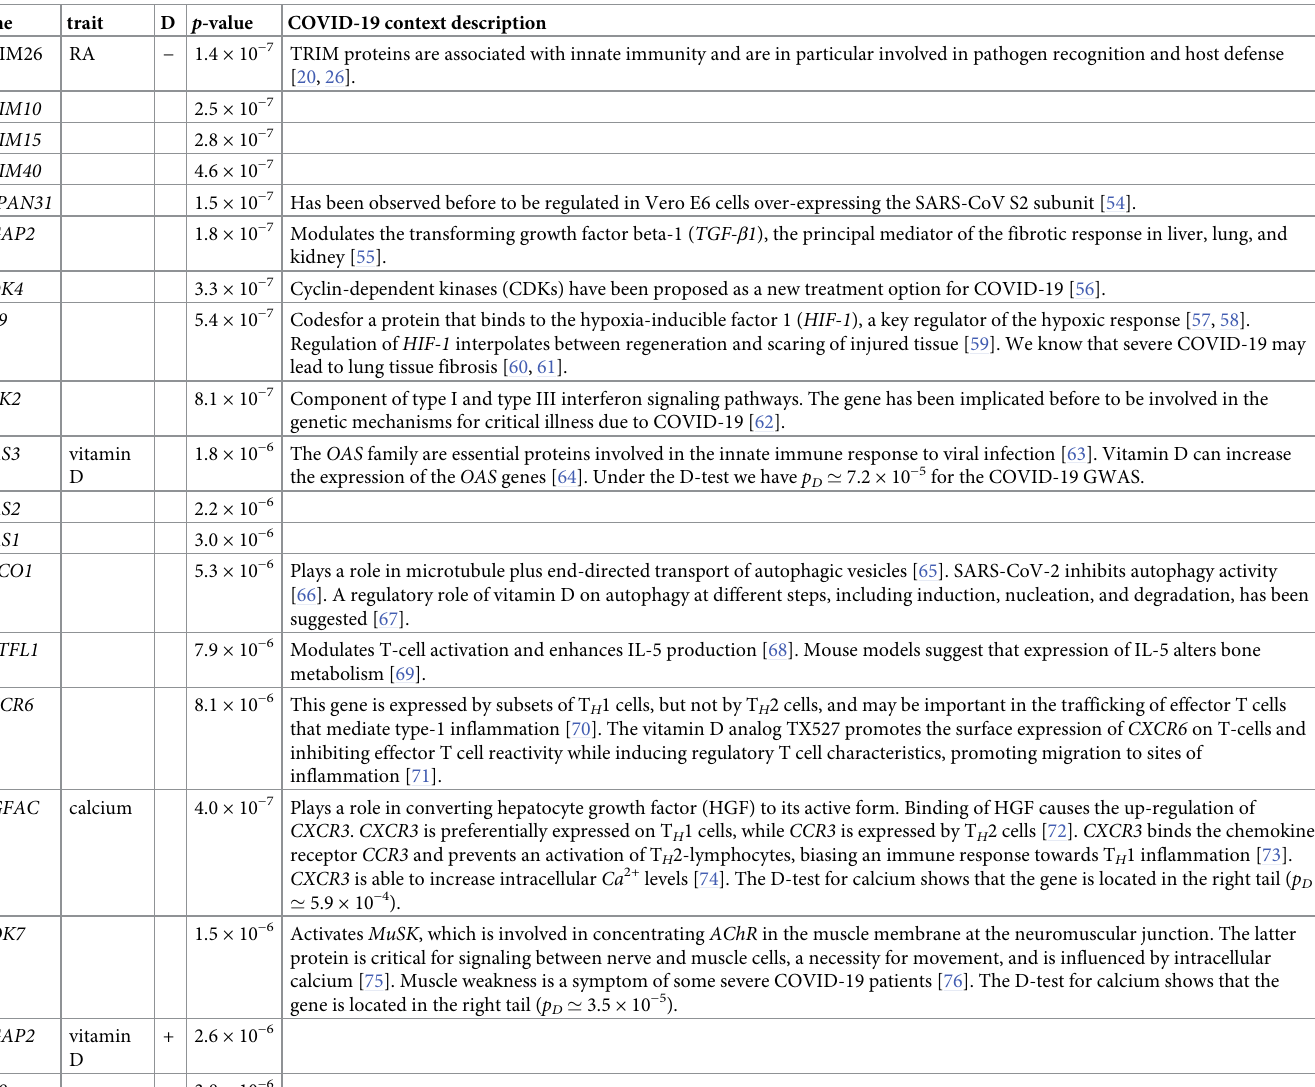
Table 2. Table of genes detected via the coherence test for COVID-19 against RA, vitamin D, and calcium (with p < 6.0 × 10 − 6 ). The column D indicates the direction of the test with + for coherent and − for anti-coherent. gene